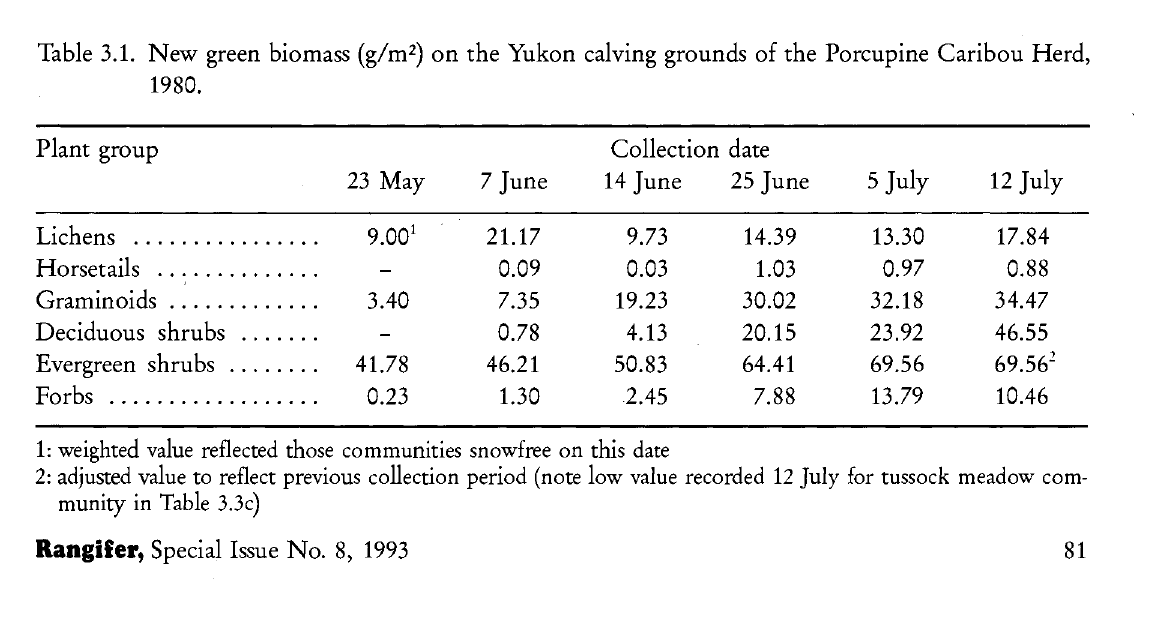
Figure 3.8. Cumulative precipitation recorded on the Por cupine caribou calving grounds, 1979-81.